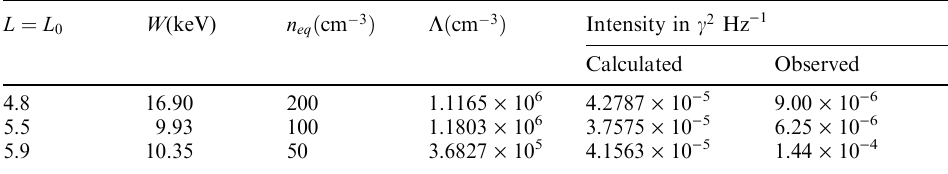
Table 1. Observed and calcu- lated equatorial intensities with other parameters